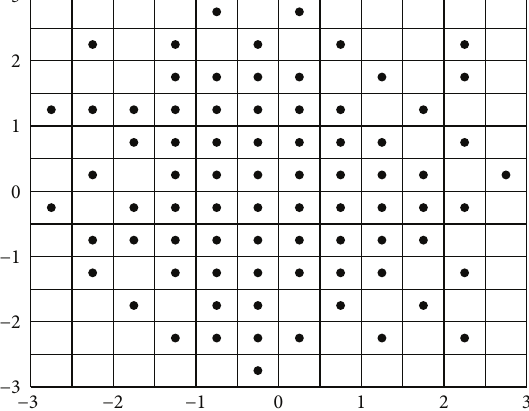
Figure 5: Array configuration for 36 elements.